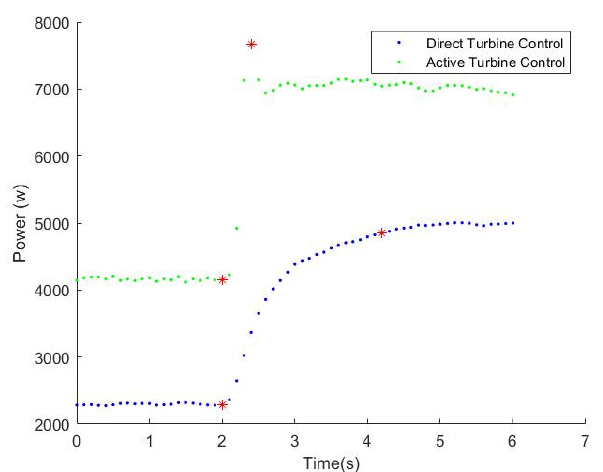
Figure 14. A comparison of power supplied by ATC and DTC systems during the 50–100% throttle experimentation.